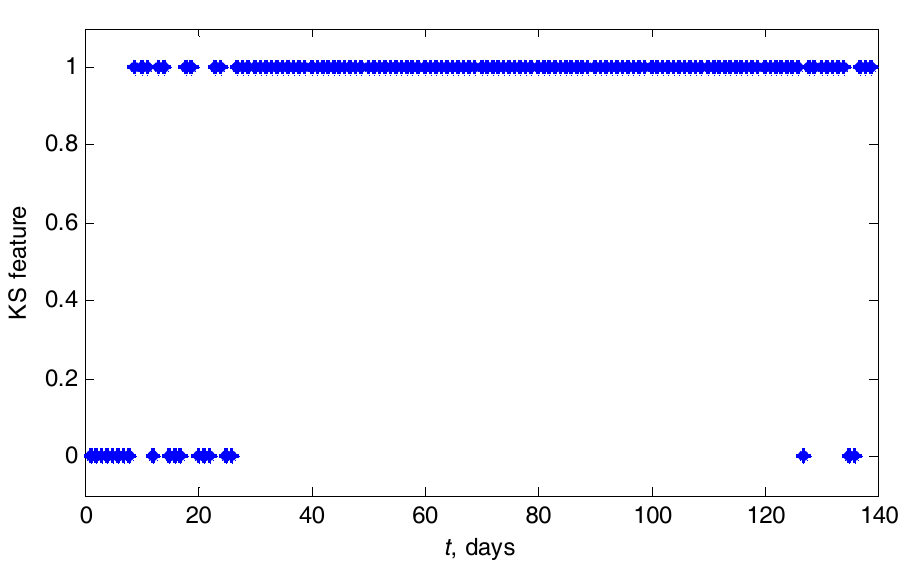
Figure 19. KS test feature calculated extracted from the vibration slew bearing signal.